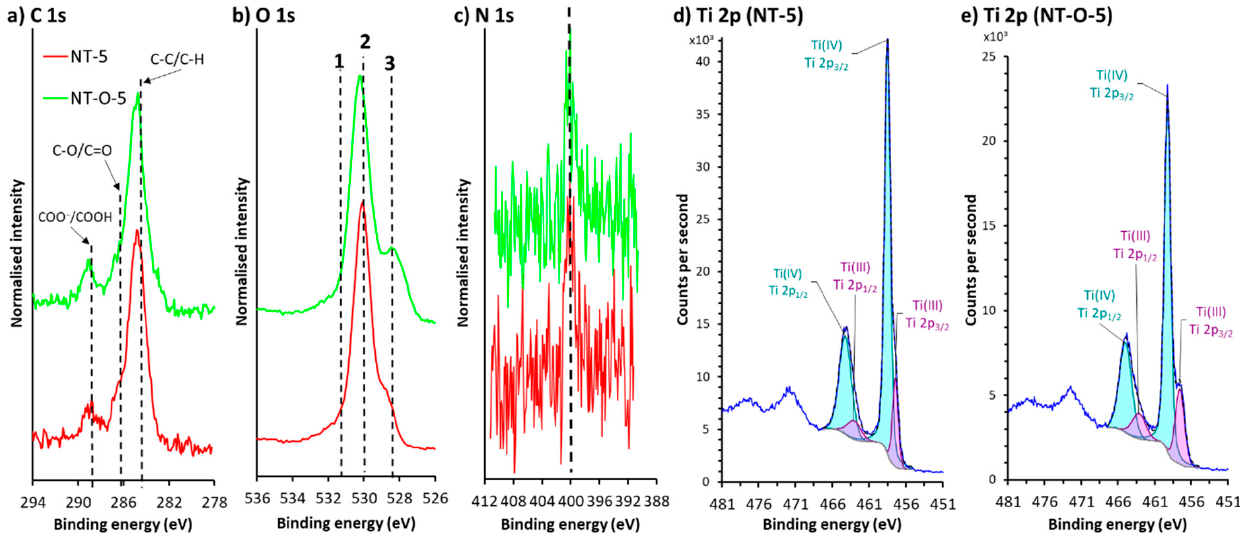
Figure 6. High-resolution XPS spectra ( a ) C 1s, ( b ) O 1s, ( c ) N 1s, and ( d ) Ti 2p for NT-5 sample, and ( e ) Ti 2p for NT-O-5 sample.